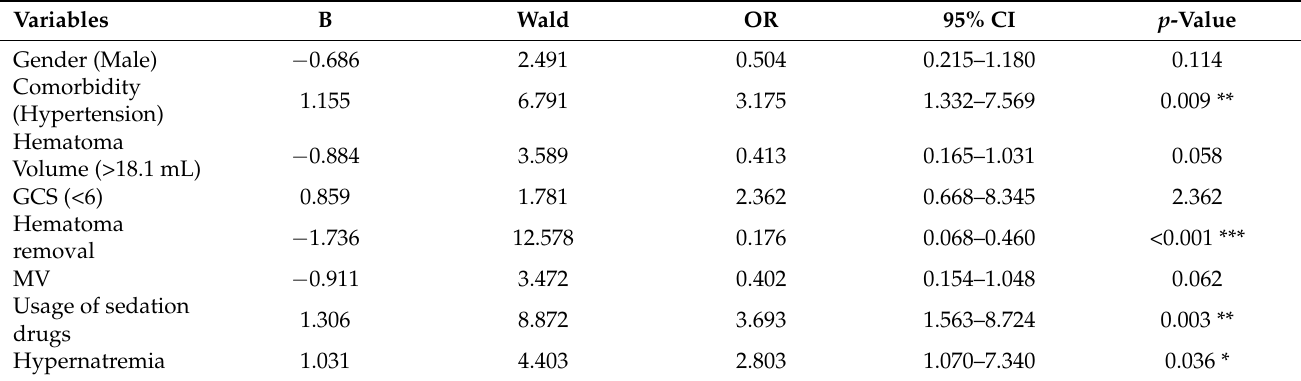
Table 2. The multivariate logistic analysis of risk factors for SHV